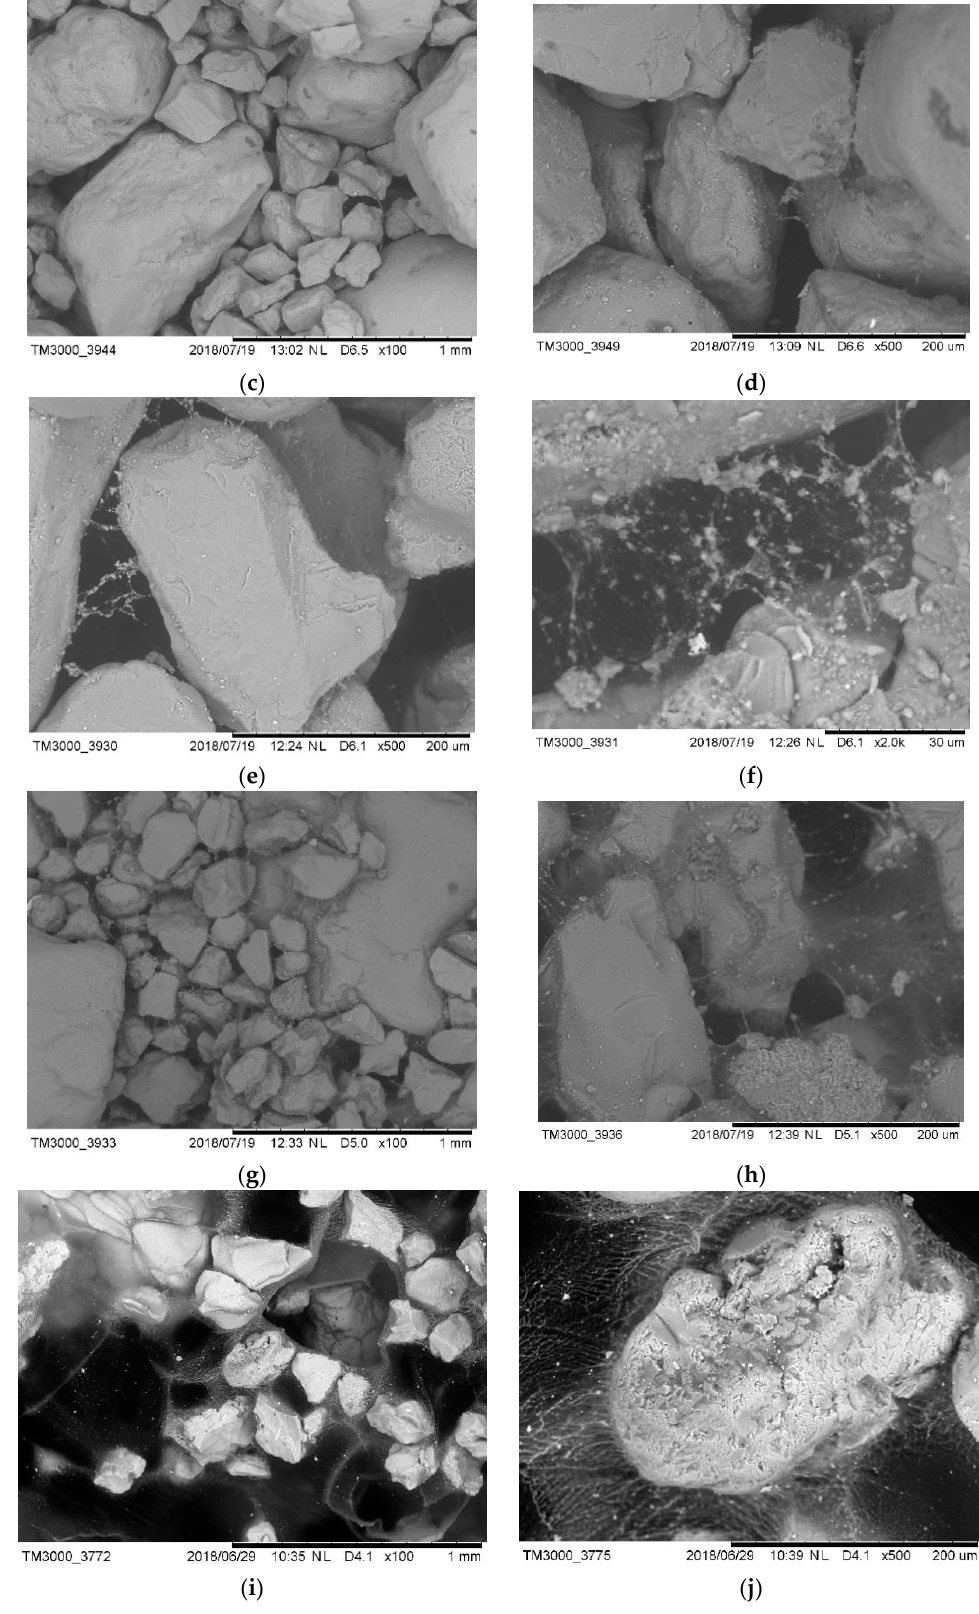
Figure 11. SEM image of standard sand in HPMC aqueous solution: ( a ) control; ( b – d ) 0.01%; ( e , f ) 0.03%; ( g , h ) 0.1%; and ( i , j ) 0.3%.